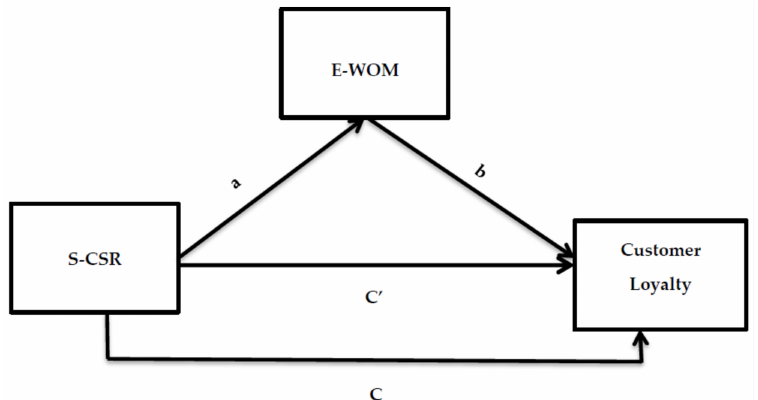
Figure 1. Proposed research model where corporate social responsibility through social media (S– CSR) = the independent variable, customer loyalty = the dependent variable, electronic word of mouth (E-WOM) = the mediating variable, C (cid:48) = indirect direct effect of X on Y with the effect of the mediator, and C = direct effect of X on Y without a mediator. a= direct path from S-CSR to E-WOM and b = direct path from E-WOM to customer